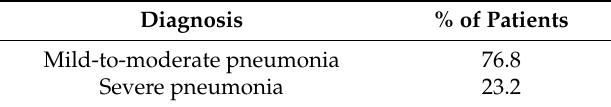
Table 1. Percentage of children with severity of pneumonia.